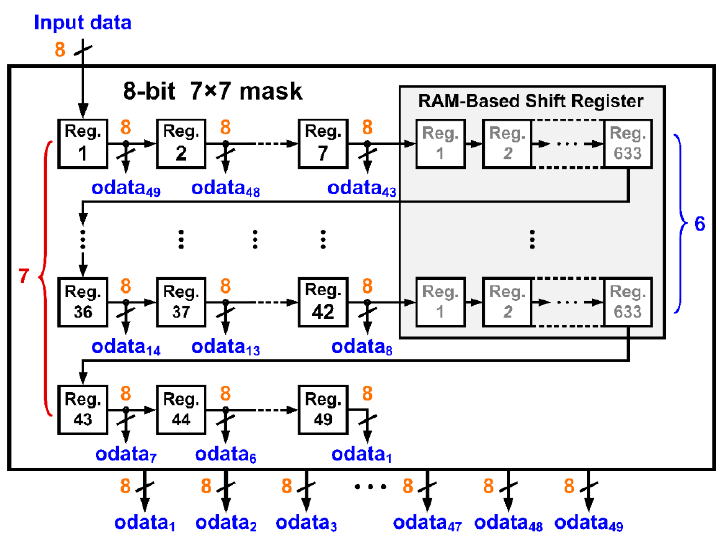
Figure 3. 8-bit input buffers for 7 × 7 mask.